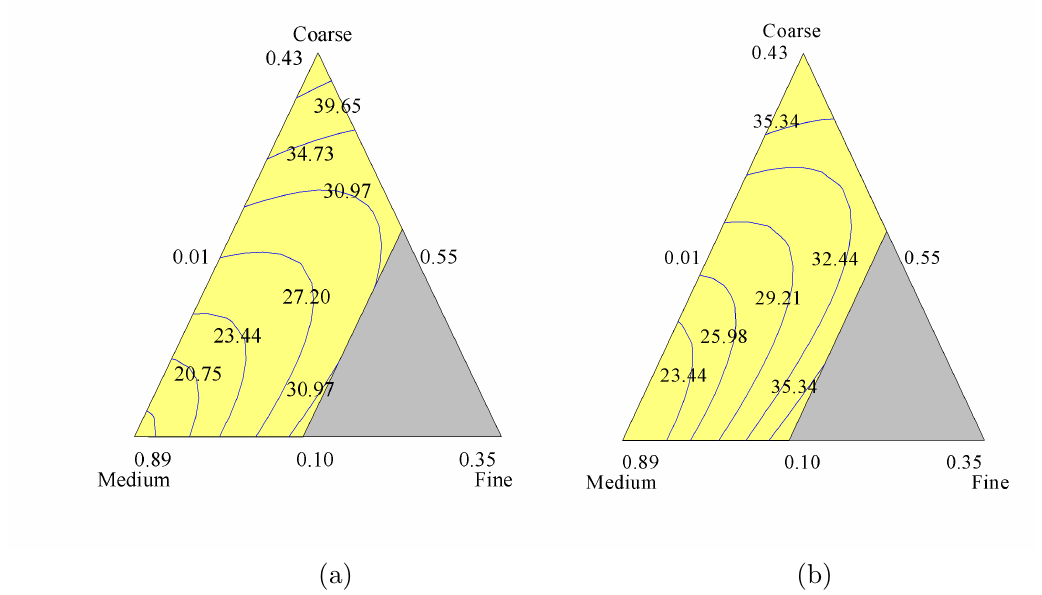
Figure 6: Effect of PSD fractions on the SD of pure gas yield production (m 3 n/t DAF) for unwashed coal: (a) Medium oxygen load and low CO 2 in RG concentration, (b) Medium oxygen load and high CO 2 in RG